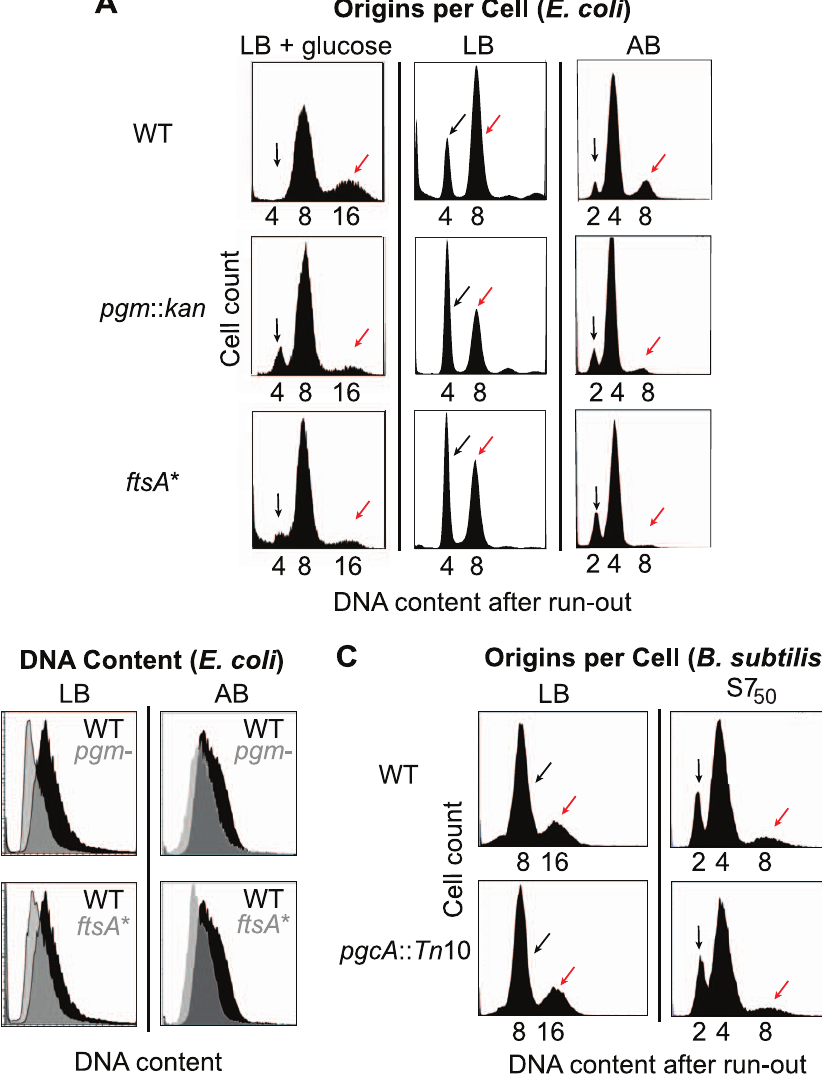
Figure 2. Examination of initiation timing in E.coli and B.subtilis . (A) Flow cytometry of E. coli wild-type and mutant cells grown after replication run-out in either LB + glucose ( left ), LB ( middle ), or AB ( right ). Black arrows indicate the cells that have not initiated replication at the time of drug addition, and red arrows indicate cells that have. Note the increased size of the uninitiated peak and decreased size of the initiated peak in the pgm :: kan and ftsA* mutant cells indicating that initiation is delayed in these strains. (B) Pairwise comparison of total DNA contents of (unsynchronized) log phase cells grown in either LB ( left ) or AB ( right ) in the absence of drugs. DNA content for wild type is in black and grey for both pgm :: kan and ftsA* . (C) Flow cytometry of the B. subtilis strains after replication run-out in either LB ( left ) or S7 50 ( right ). Note the small B. subtilis mutant has the wild-type equivalent origins per cell, indicating the timing of replication initiation is normal in this background. 81 6 4% of wild type values, respectively (Figure 2B, left ). The corresponding values in AB were 87 6 4% and 82 6 6%, respec- tively (Figure 2B, right ). These results are consistent with an initiation delay in the mutants.